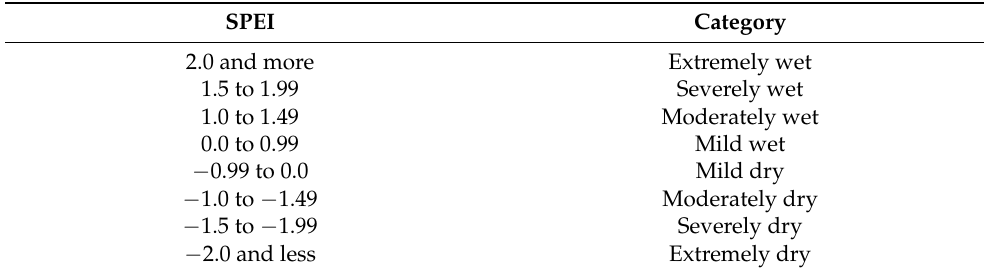
Table 1. Classification of Standardized Precipitation–Evapotranspiration Index (SPEI) values accord- ing to their magnitude. Adapted from